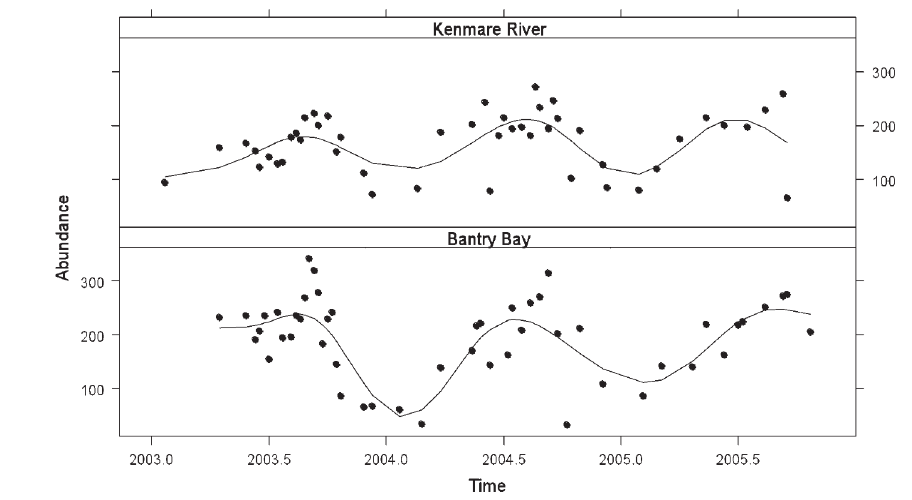
Fig. 2. Seasonal changes in haulout counts in each bay. The smoothing line was added to aid visual inter-